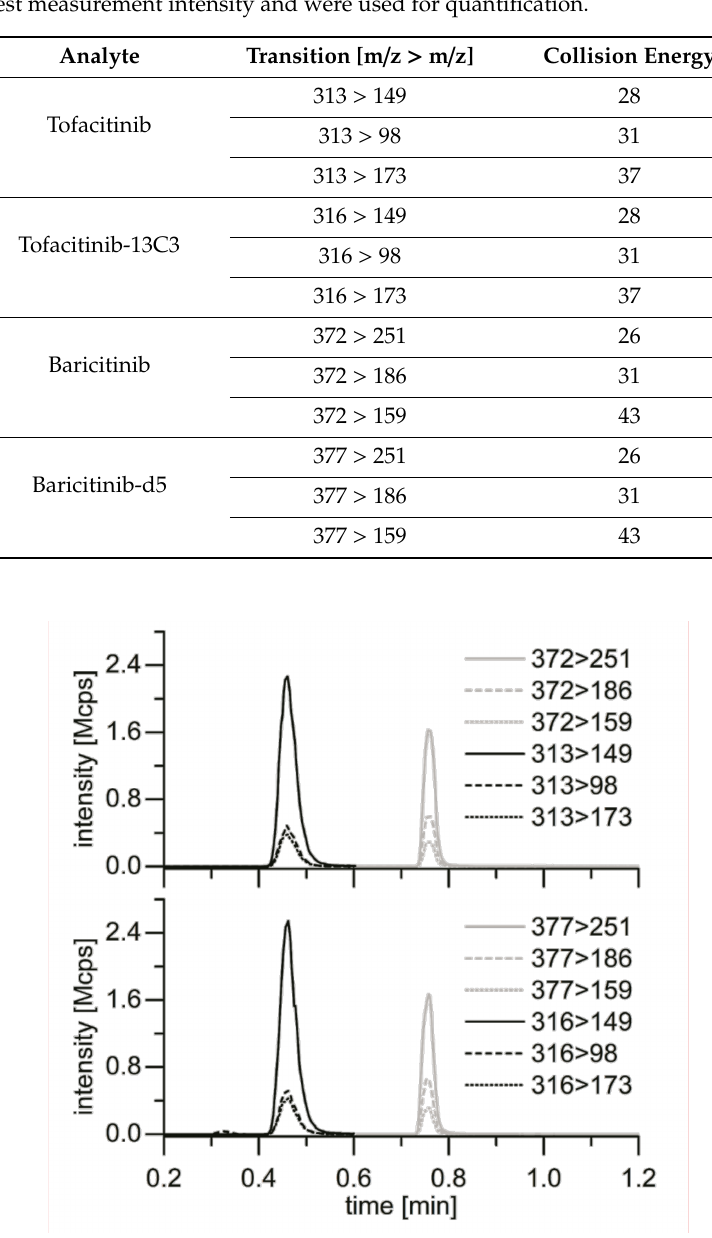
Figure 5. Transitions of Baricitinib and Tofacitinib (above) and IS (below). Tofacitinib is shown to the left in black, to the right Baricitinib in